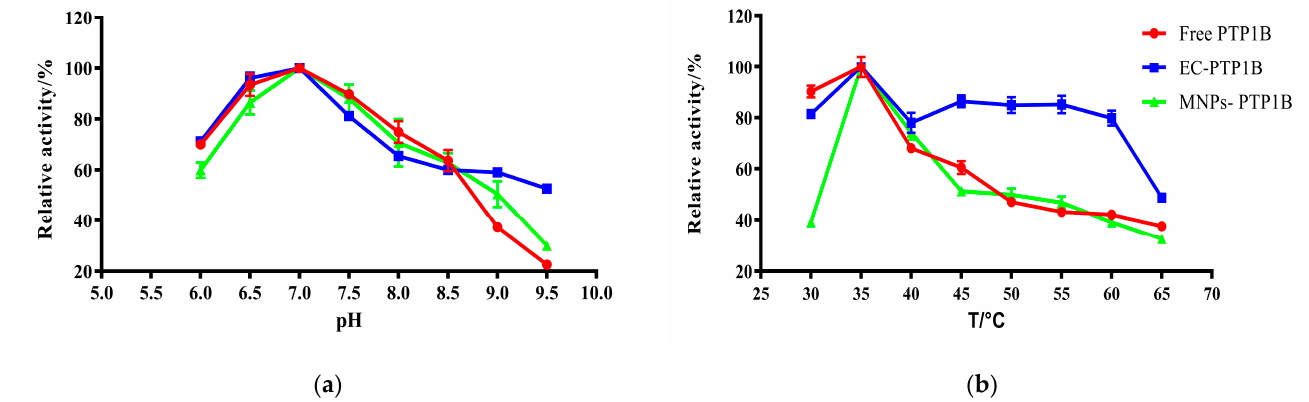
Figure 3. Effect of pH ( A ) and temperature ( B ) on the activity of free PTP1B, MNPs-PTP1B, and displayed PTP1B cells.